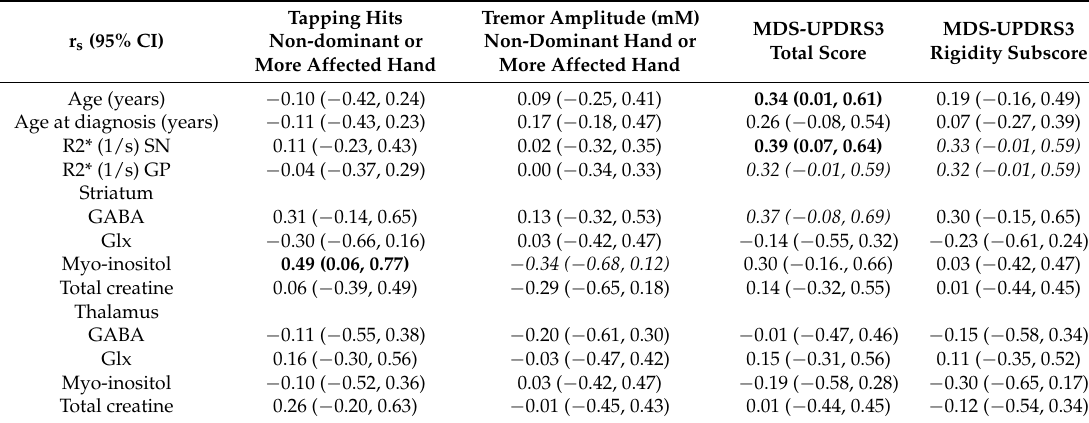
Abbreviations: MDS-UPDRS3: Movement Disorder Society-Sponsored Revision of the Unified Parkinson Disease Rating Scale part III, R: relaxation rate, SN: substantia nigra, GP: globus pallidus, GABA: γ -aminobutyric acid, Glx: glutamate and glutamine, rs: Spearman correlation coefficients (for neurometabolites partial correlation coefficients adjusted for CSF content in the voxels using data from the hemisphere contralateral to the non-dominant hand for tapping hits and tremor amplitude), CI: confidence interval (significant effects marked in bold and marginal effects marked in